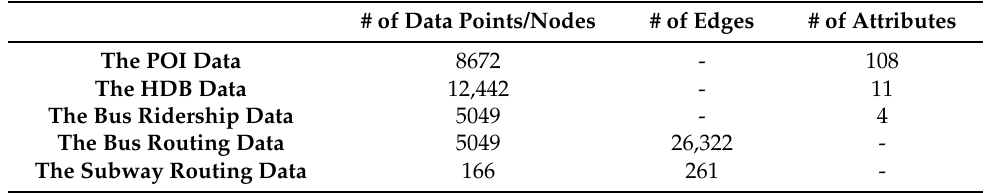
Table 3. An overview of the LTSG